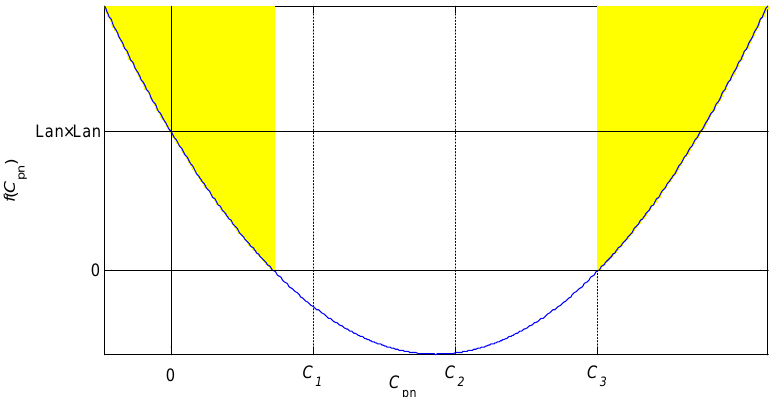
Figure 5. Damped cases of the system determined by the value of f ( C pn ).